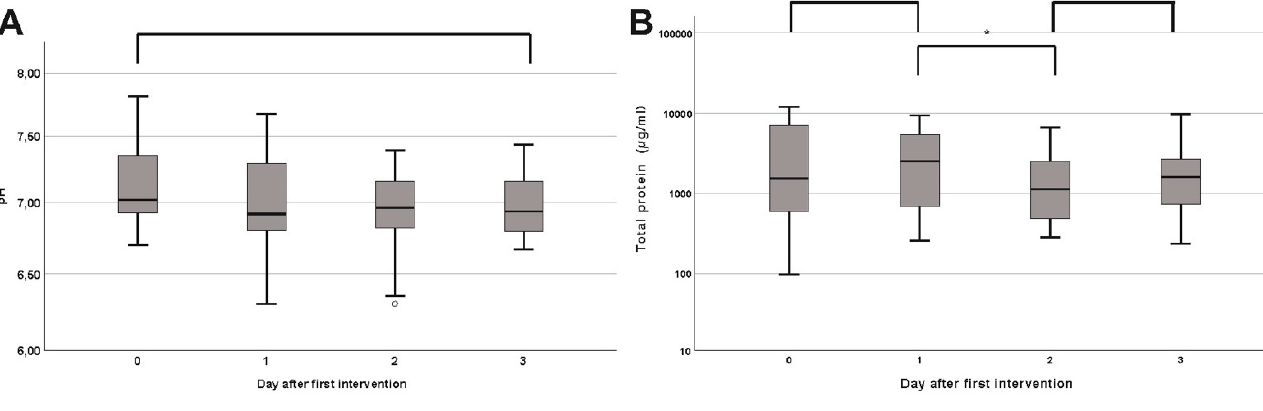
Figure 2. Boxplots of the pH-value ( A ), potassium (mmol/L) ( C ) and total protein (µg/mL) ( B ) on the day of the operation (0.) and first to third postoperative day. Stars and circles indicate extreme values exceeding the 95% confidence interval. The asterisk (*) indicates significance. 4. Discussion Vacuum therapy is undoubtedly an effective tool in the treatment of acute and chronic wound conditioning [19,20]. However, the underlying mechanisms are not con- clusively understood and clinical monitoring between dressing changes is limited. In an attempt to further contribute to the understanding of NPWT(i) and establish a monitoring tool for the clinical routine during the NPWT treatment phase, we analyzed the rinsing fluid of NPWTi devices in a pilot study. We were able to quantify significant levels of potassium, phosphate, lactate dehydroxygenase (LDH), pH and the amount of protein as well as identify different cells in the disposed rinsing fluid. As locally produced biomarkers, these parameters might provide additional information on the wound status without changing the dressing. Previous studies have suggested that wound fluid is a systemic mirror containing important information about the inflammatory response. Polykandriotis et al. analyzed the wound exudate in NPWT draining lines and measured the levels of systemically ad- ministered antibiotics. They were able to detect almost two thirds of the plasma concen- tration in the draining fluid one hour after intravenous administration [15]. Moues et al. investigated the influence of NPWT on the extracellular collagenous matrix components and used a polyvinylidene fluoride filter to collect the wound fluid. Significant levels of albumin, matrixmetalloproteinases and tissue inhibitors were found as an expression of biochemical markers reflecting parts of the intracellular response [21]. It is not yet clear how precisely the diluted wound exudate mirrors the healing cascade, and, in contrast to invasive punch biopsies, a complete genomic and proteomic evaluation remains challeng- ing. However, we were able to quantify significant levels of various electrolytes and cell components in the rinsing fluid of NPWTi devices. Several interesting observations are